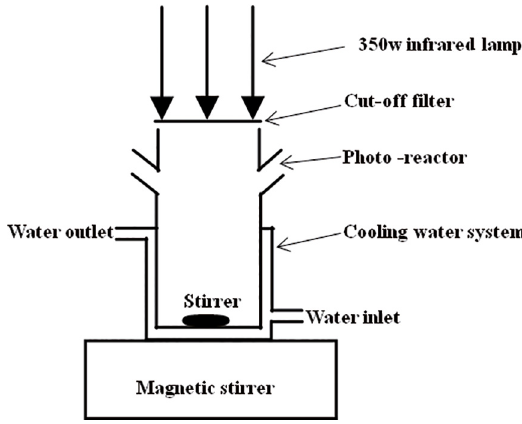
Figure S2: The picture of scheme of our experimental photocatalytic